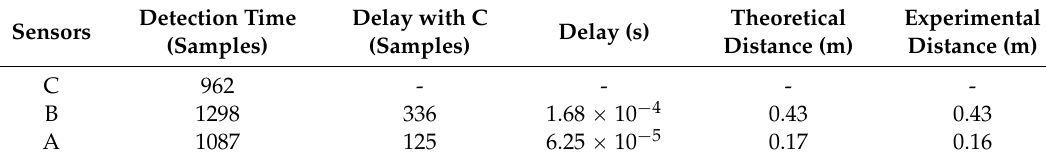
Table 5. Third case study: detection time; delay with C; delay; theoretical distance; experimental distance.